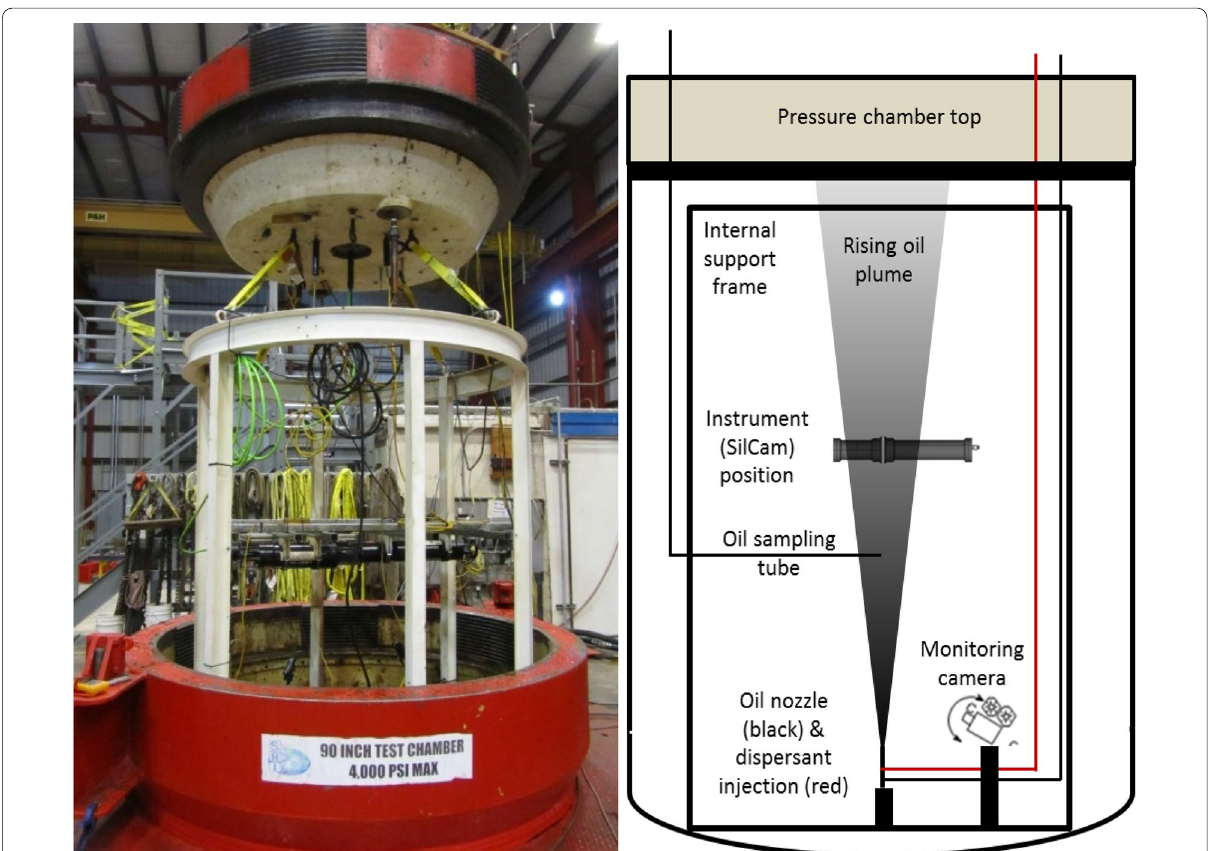
Fig. 3 Pressure chamber for oil spill tests. Top left: Pressure chamber open and ready for insertion of the monitoring frame with the SilCam. Top right: Schematics of the experimental set-up (Brandvik et al.